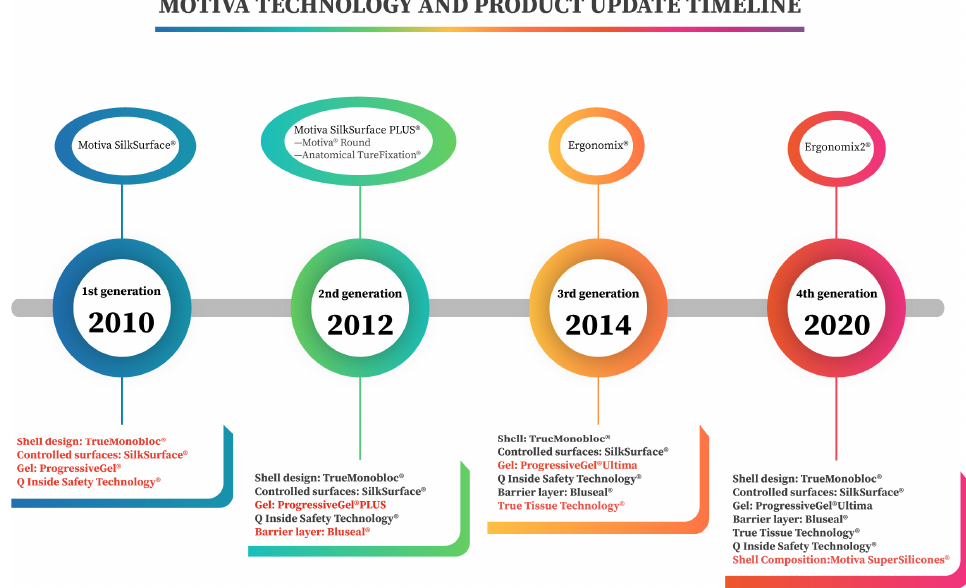
Figure 1. Timeline for Motiva technology and product update.